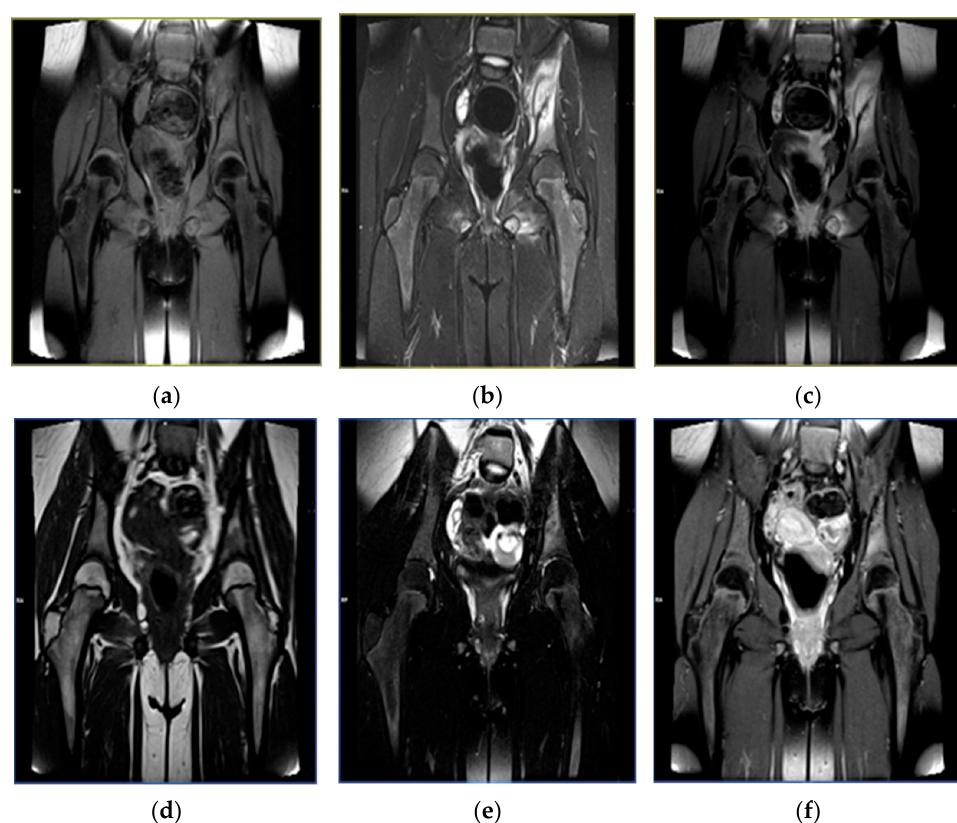
Figure 2. Magnetic resonance images in a 10-year-old female patient with inflammatory lesions around the left sacroiliac joint. Status before treatment: T1-weighted sequence ( a ), T2-weighted sequence ( b ), T1-weighted sequence with contrast enhancement ( c ). Status after a 19-month follow- up, with partial regression of the inflammatory lesions: T1-weighted sequence ( d ), T2-weighted sequence ( e ), T1-weighted sequence with contrast enhancement ( f ).